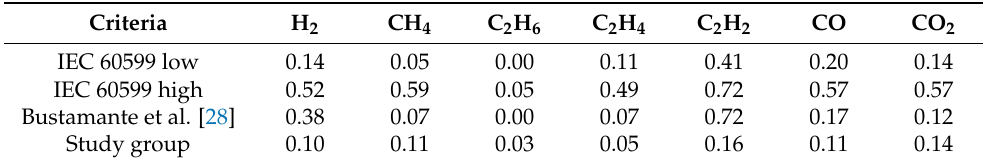
Table 5. The impact of the 90th percentile gas level increase between successive sampling on the health index score.